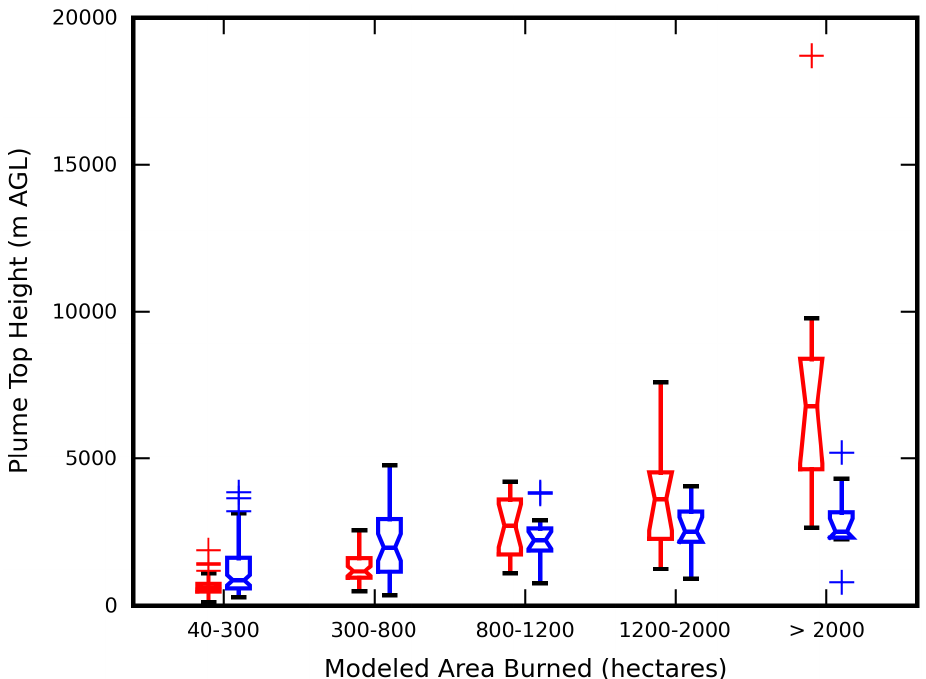
Figure 7. Notched box-whisker plot of modeled (red) and MISR observed (blue) plume heights as a function of modeled area burned. The notch is centered on the median concentration, widening to the size of the box to illustrate a 95% confidence interval in the median concentration value. The edges of the box illustrate 25th and 75th percentile concentrations. The whiskers indicate the lowest and highest values that are within 1.5 times the interquartile range (IQR). Outliers (denoted by plus signs) fall between 1.5 and 3 times the